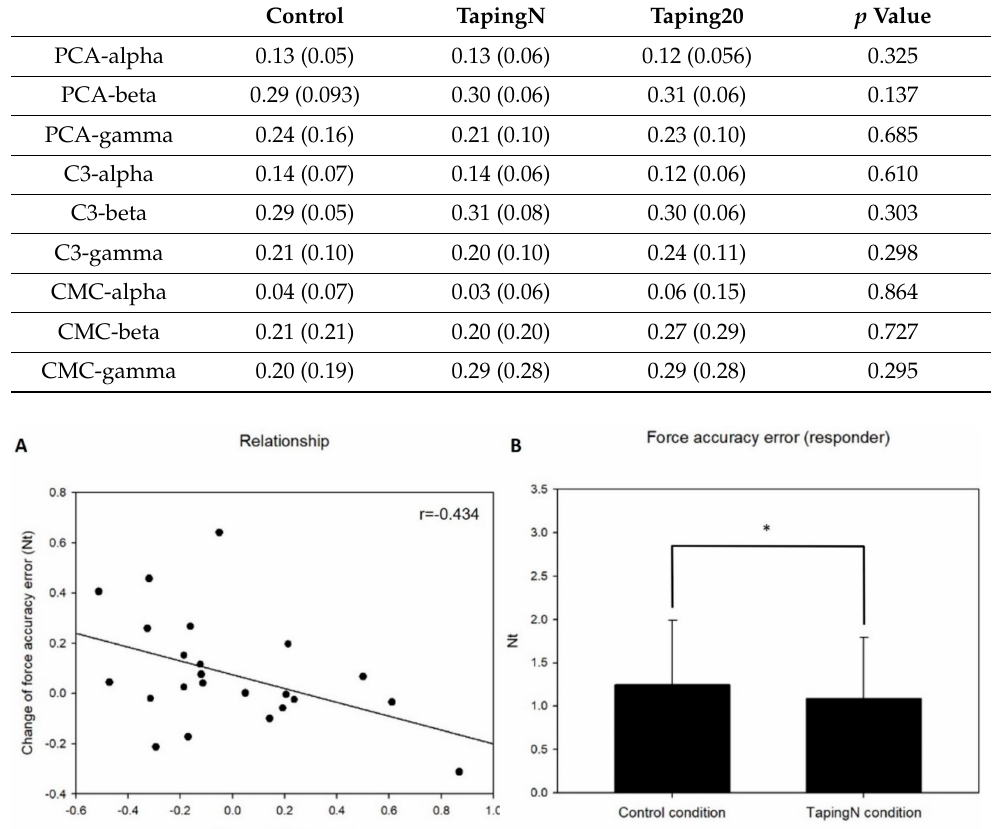
Table 2. EEG and corticomuscular coherence values for the three different taping conditions.